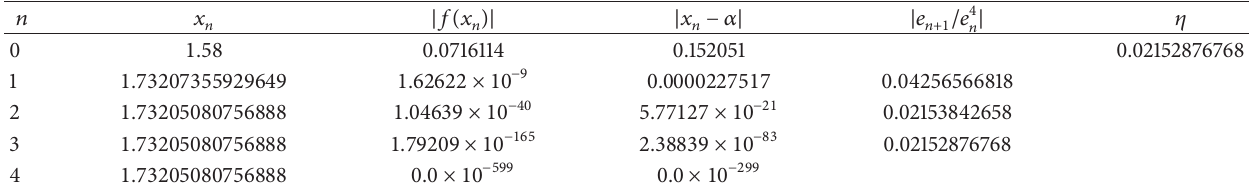
Table 2: Convergence behavior with 𝑓(𝑥) = cos (𝜋𝑥 2 /6) log (𝑥 2 − √3𝑥 + 1), (𝑚,𝜆,𝜌) = (2, 5, 5) , 𝛼 = √3 .